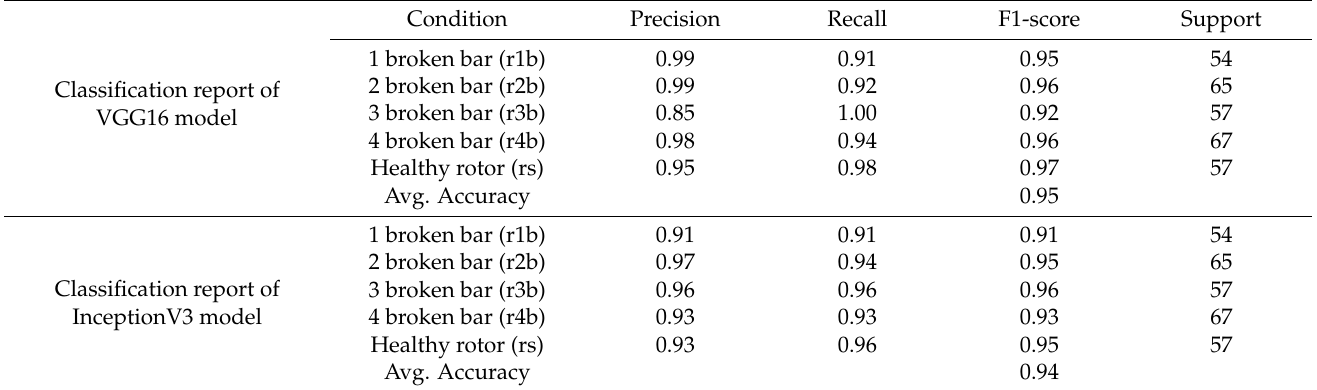
Table 4. Show the classification reports of transfer learning CNN network